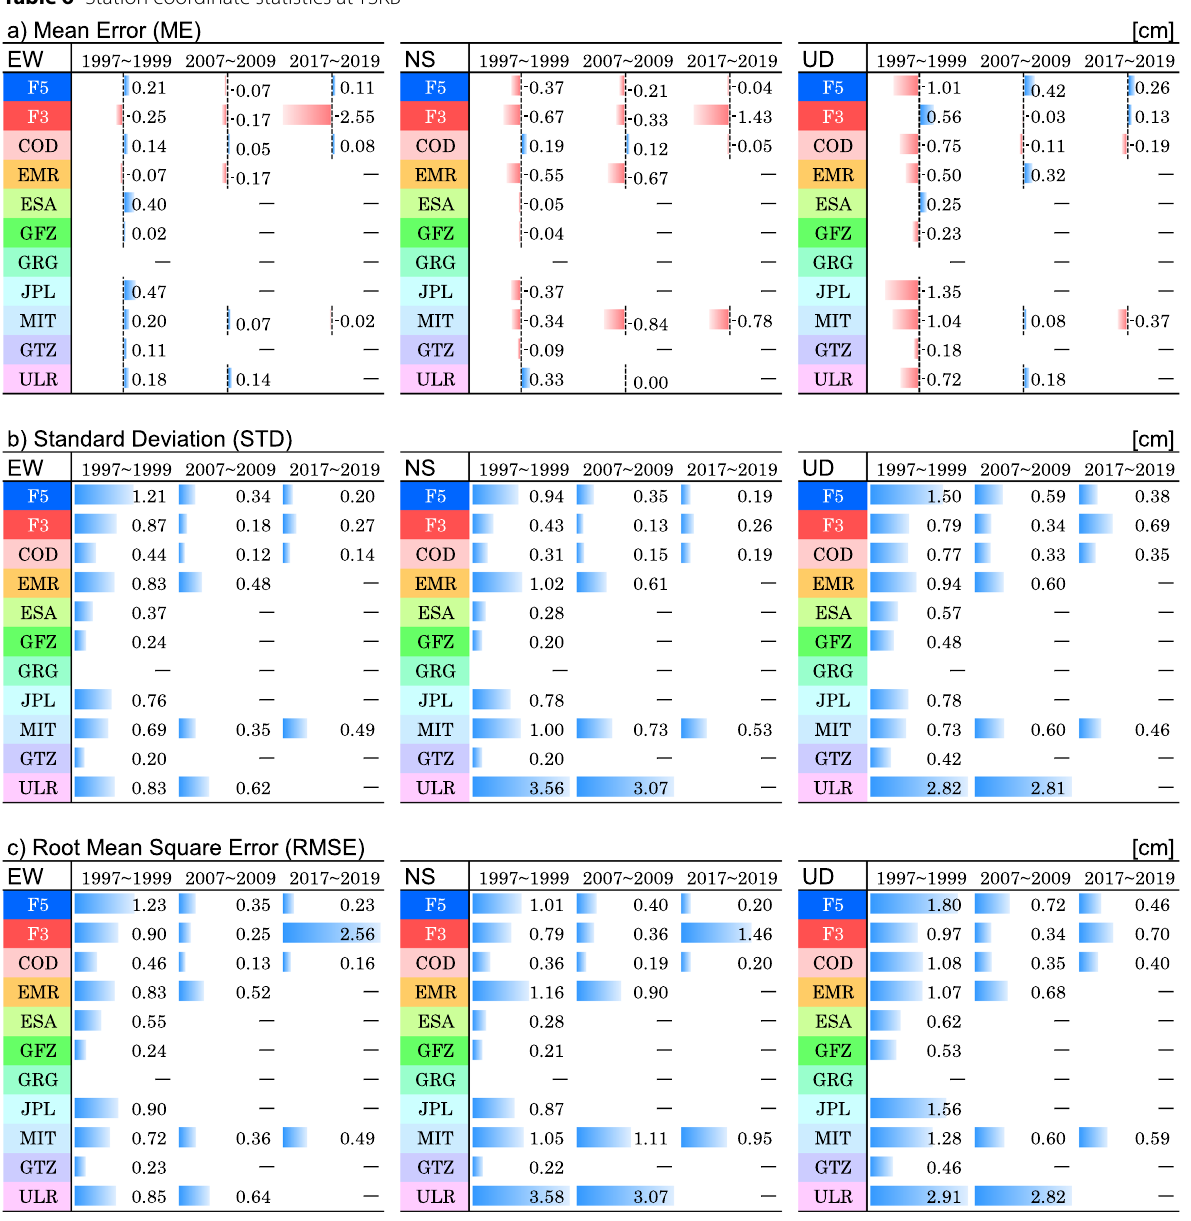
Table 6 Station coordinate statistics at